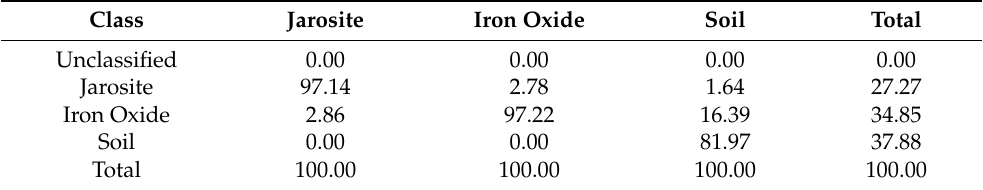
Table A12. March 2019 spectral angle mapper. Overall accuracy points: 119/132, overall accuracy: 90%, kappa coefficient: